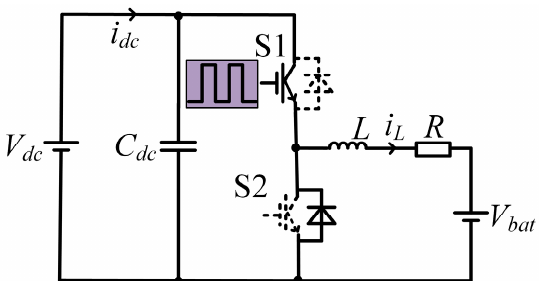
Figure 3. Principle diagram of bidirectional DC/DC converter working in buck mode.